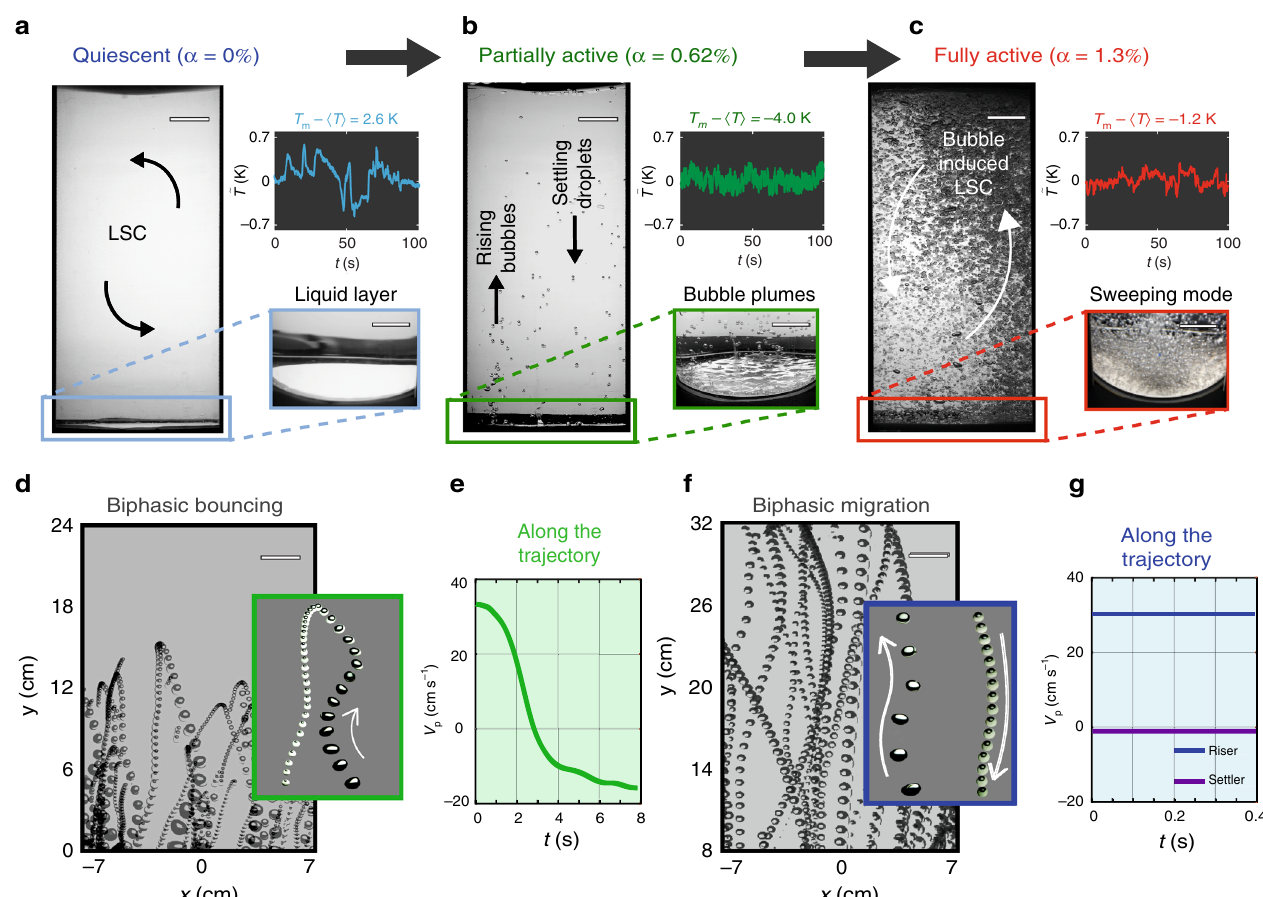
Fig. 2 Representative stages of heat exchange process. Three identi fi able stages revealing increasing levels of biphasic particle activity (see Supplementary Movies 4 and 5), namely a single-phase regime ( T b − T cr < 0 K), b partially active regime (0 K < T b − T cr < 5 K), and c fully active regime ( T b − T cr > 5 K). Insets (snapshots) of a – c show the zoom-in views of the bottom plate (see Supplementary Movies 6 and 7). Insets (data plots) of Fig. 2 a – c show temperature time-series measured in the bulk of the set-up. T m = ( T b + T t )/2 is the system mean temperature, T is the time-averaged temperature. d Biphasic bouncing regime observed under partially active condition (see Supplementary Movie 8). Inset (snapshot) reveals the detailed kinematics of a representative biphasic particle, with both particle size and velocity changing during its rise and fall. The particle velocity V p evolving with time is shown in e . f Biphasic migration regime, observed at a higher activity level. Here, the particles migrate from bottom plate to top plate and vice versa (see Supplementary Movie 9). Inset shows typical riser and settler trajectories. g Evolution of V p for riser (blue) and settler (purple) particles in time. The velocity shown in e , g is the vertical velocity, with positive denoting upward travel of the biphasic elements, and negative denoting downward motion. Scale bars: 50 mm in a – c ; 25 mm in d and